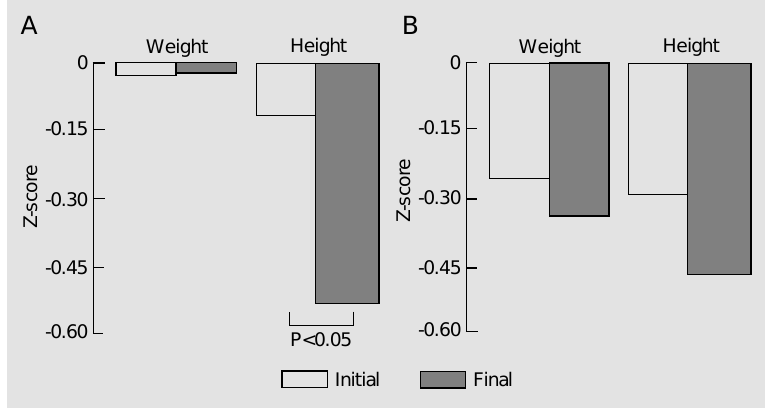
Figure 3. Weight and height Z-score at diagnosis and at final evaluation in type 1 diabetic girls (A) and boys